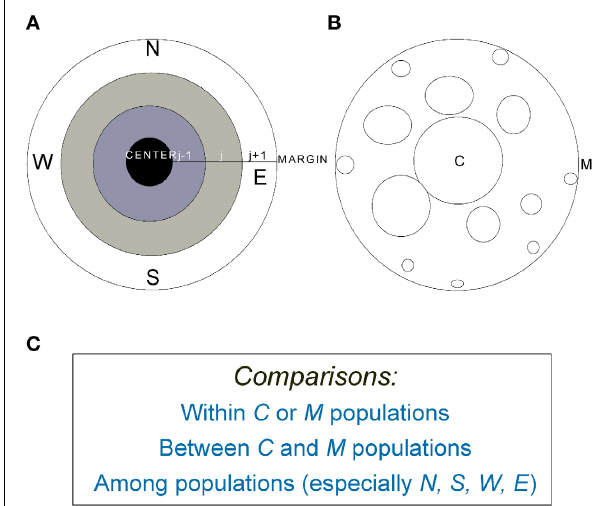
FIGURE 2 | (A) A graphic representation of an idealized species’ range in which population density declines from the range center ( C ) to margin ( M ). (B) The average patch size or population size decreases from center to margin but isolation increases. (C) Examples of common comparative strategies within, between, and among populations across species’ ranges (e.g., Bakker et al., 2006; Soley-Guardia et al., 2014). For marginal populations, between ( N-S , for example) and among-population comparisons can be made in four major directions ( N, S, W, and E